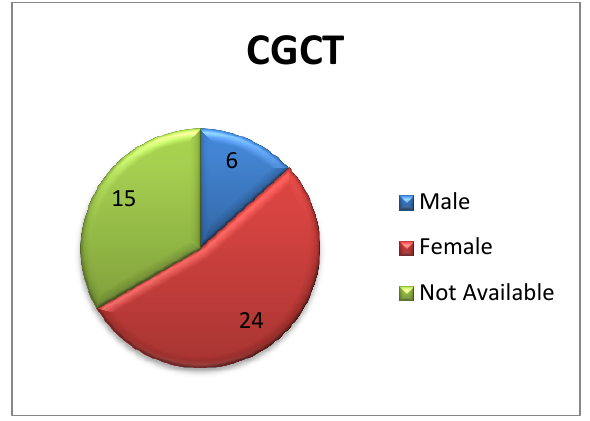
Figure 2: Gender distribution Differential Diagnosis